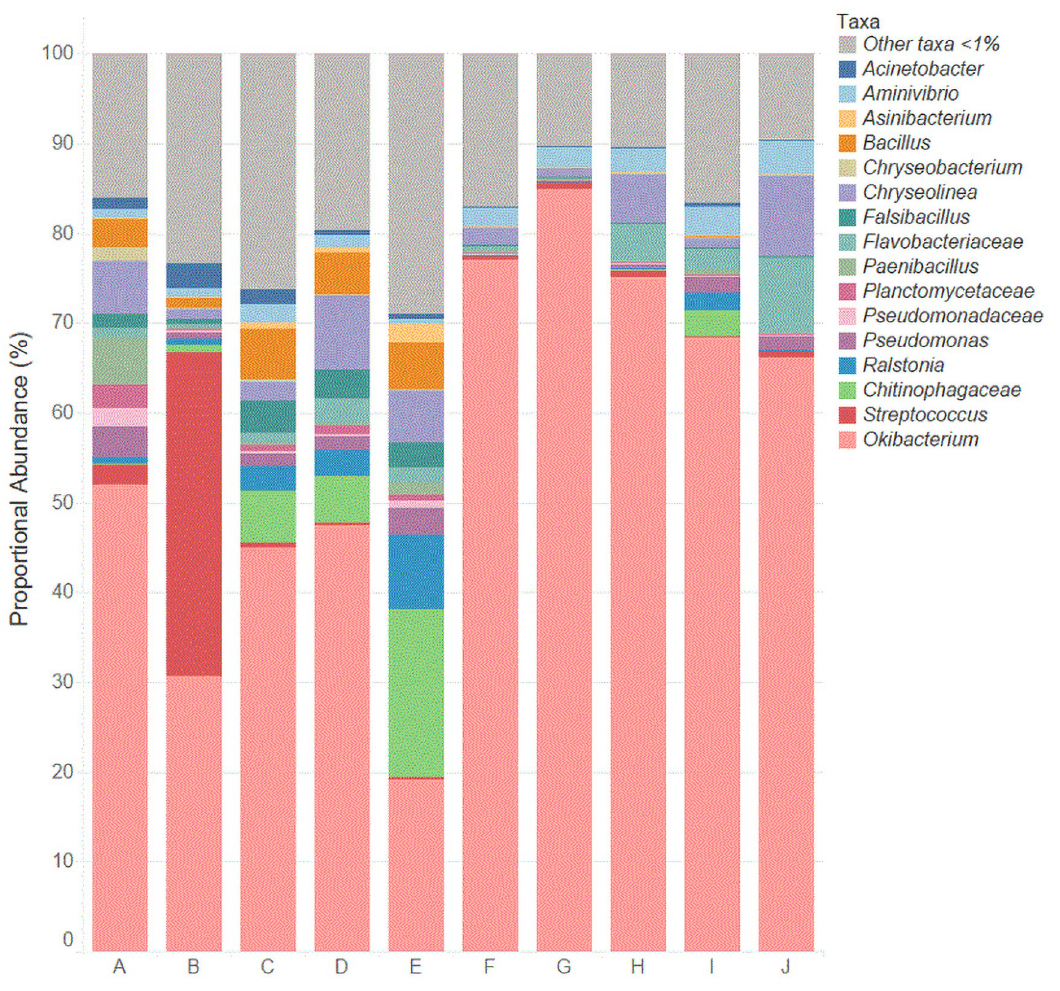
Fig 4. Relative abundance of unique taxa in the 10 brands of sesame